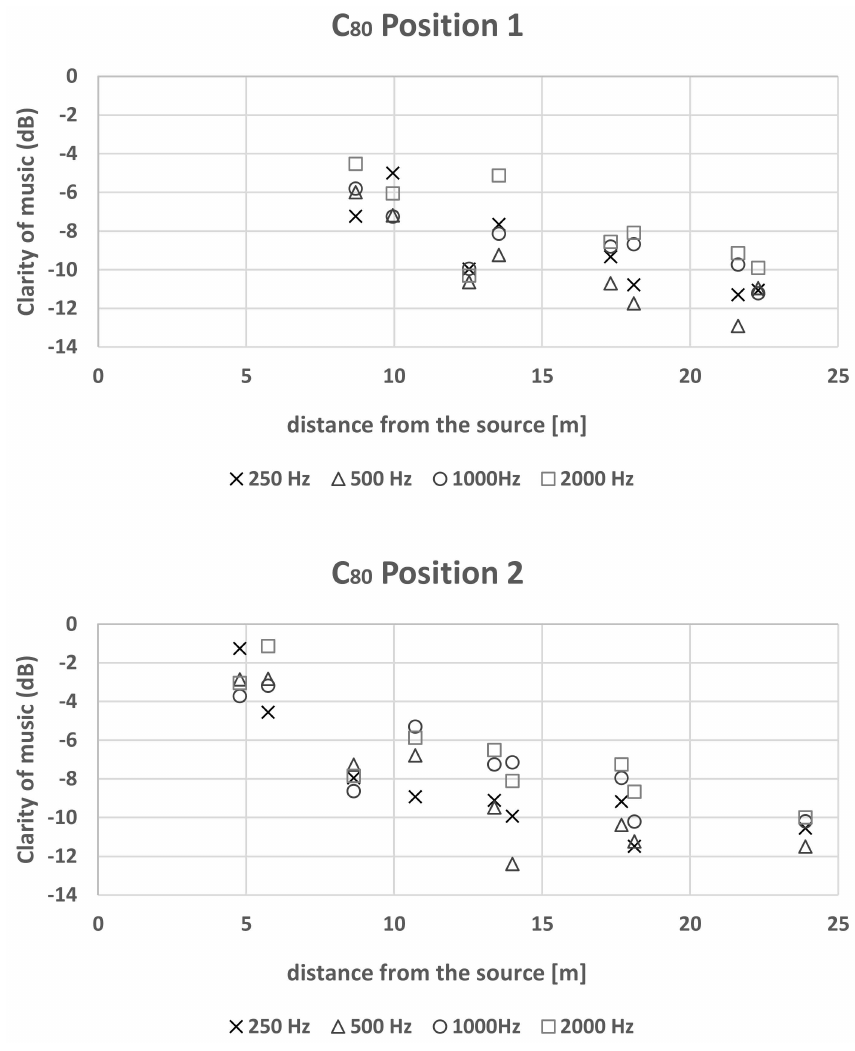
Figure 14. C 80 vs. distance from the source position 1 ( top ) and 2 ( bottom